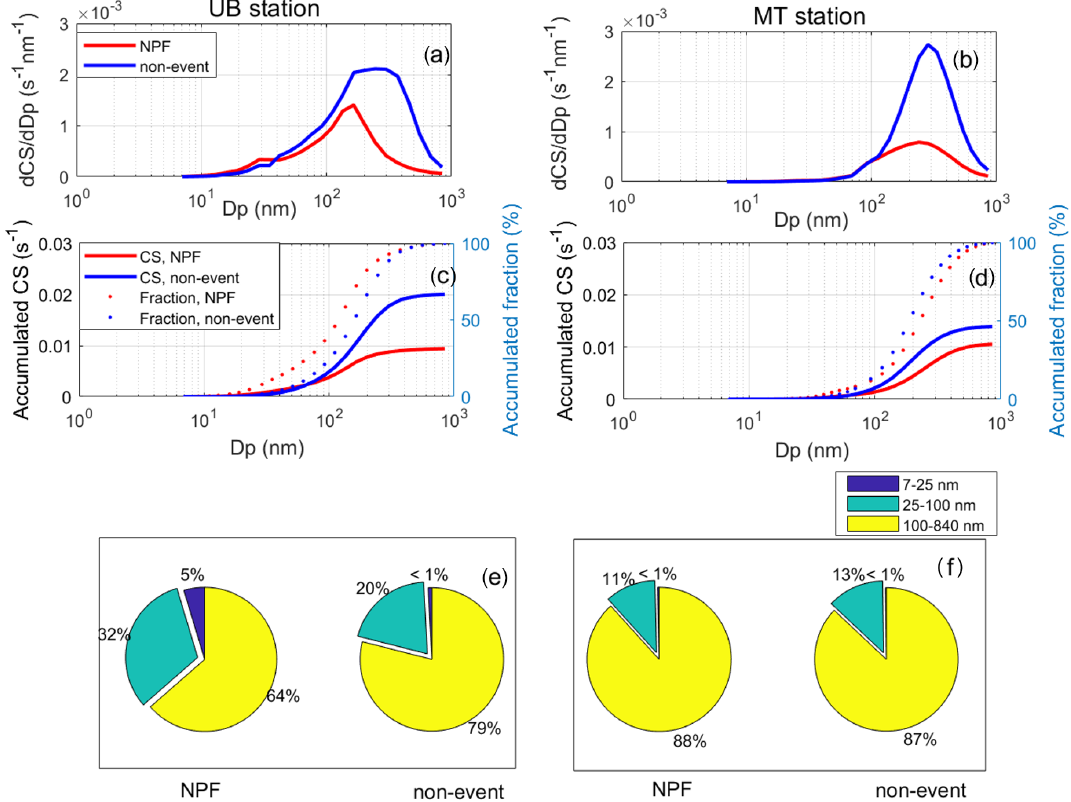
Figure 6. Median CS size distribution (a, b) , accumulated CS contributed by particles from 6nm and the ratio between accumulated CS and total CS (c, d) . Contribution of size-segregated particles to total CS (e, f) at each site on NPF and non-event days during 09:00–15:00LT. The left and right panels represent data observed at the UB and MT site, respectively. The time resolutions for CS and particle number concentration data were 8min at the UB station and 4min at the MT station,